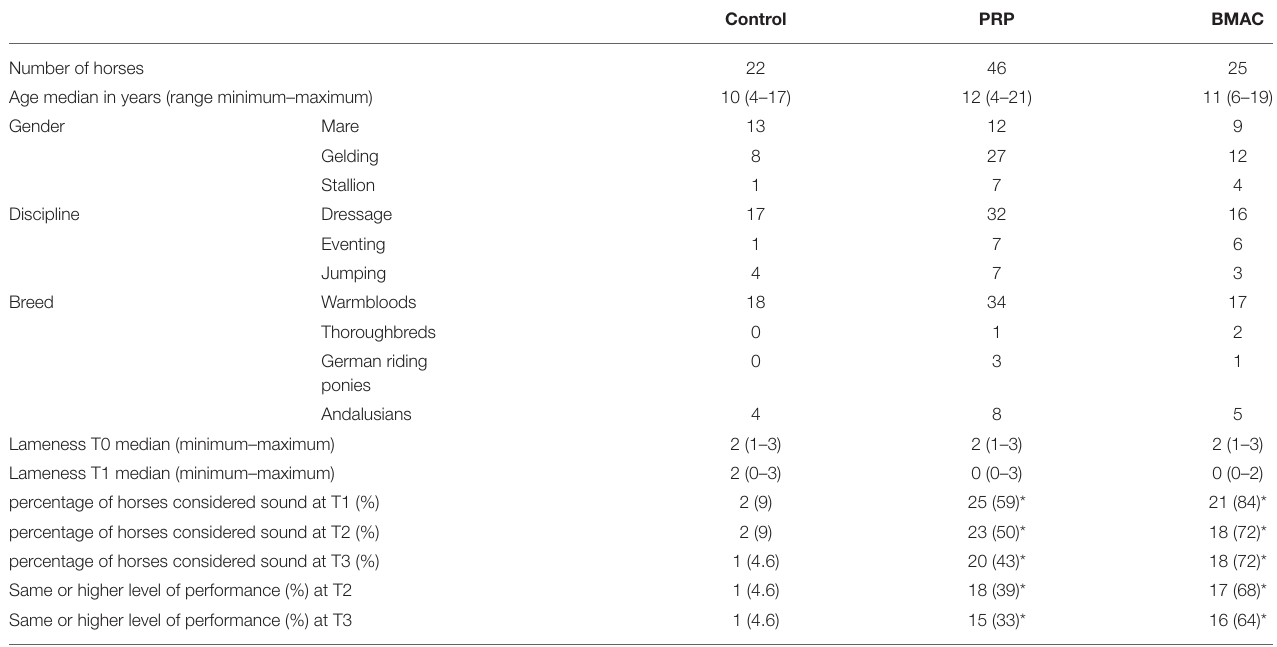
Control PRP BMAC